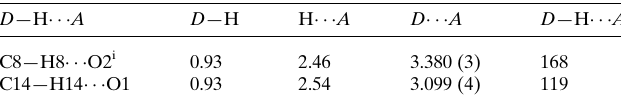
Table 1 Hydrogen-bond geometry (A˚ , (cid:3) ) for p-bSe.